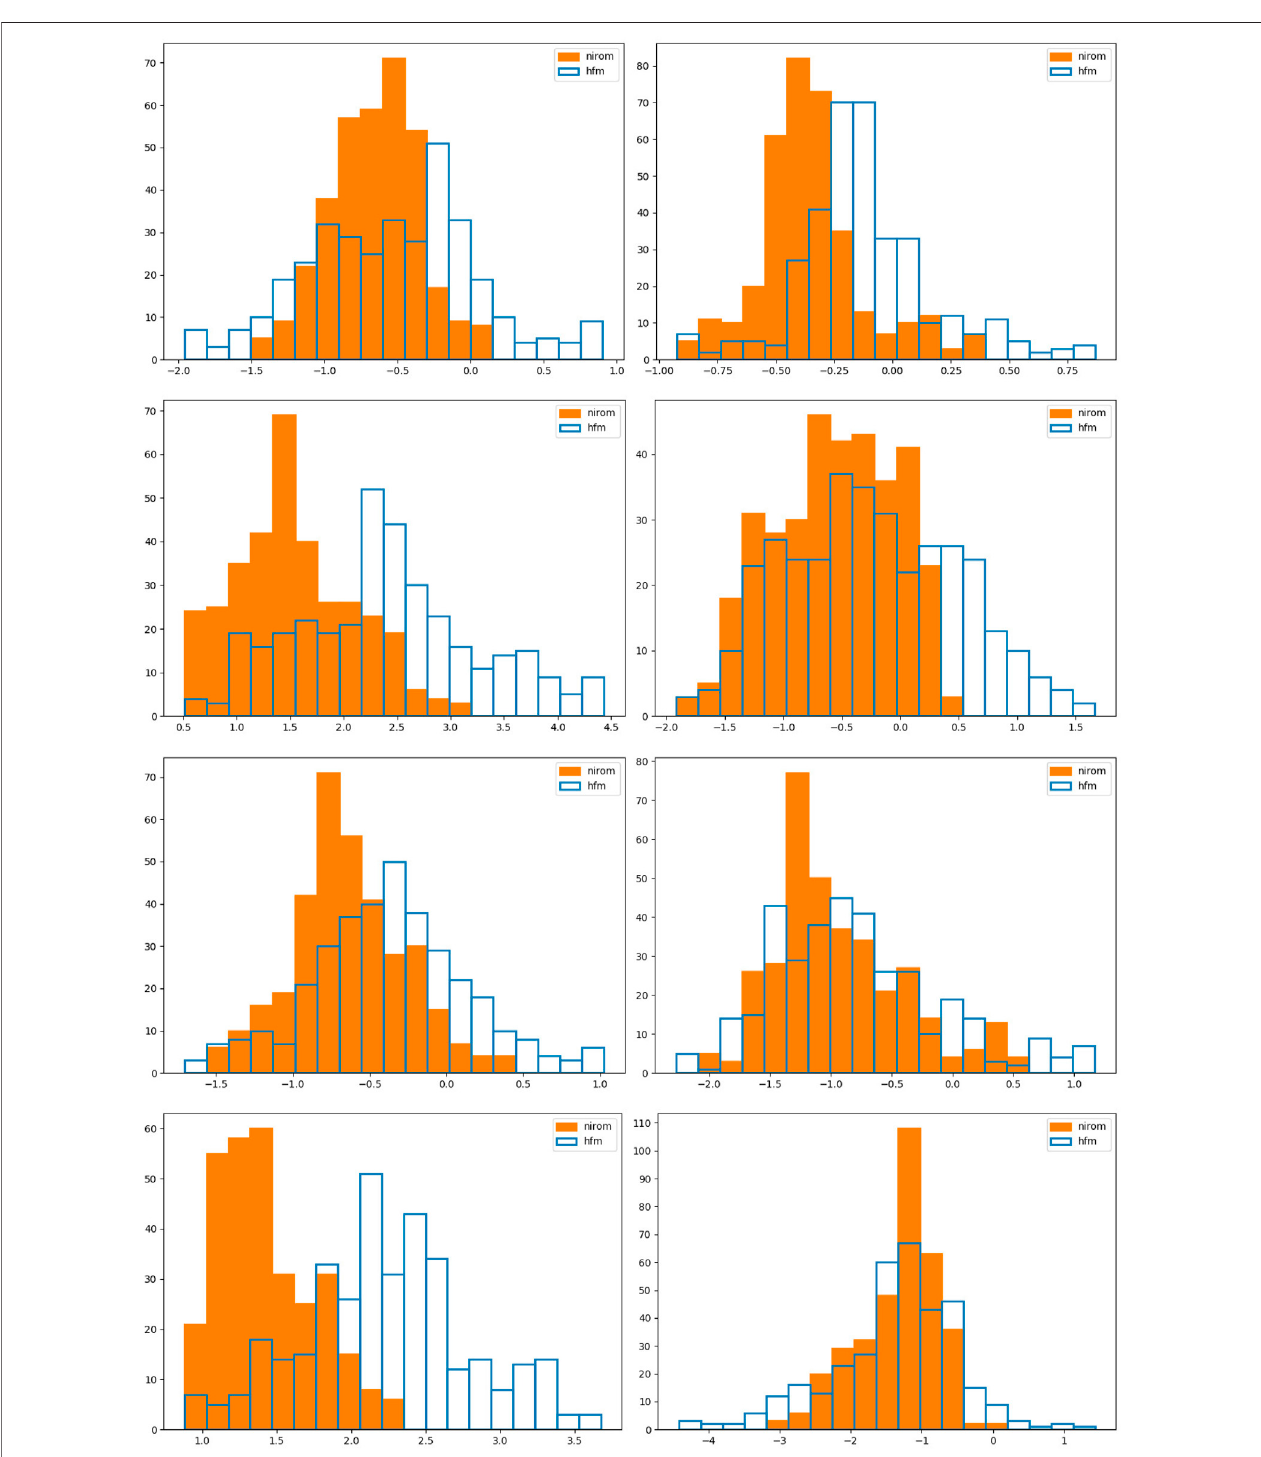
FIGURE 9 | Here we show histograms for the 6 by 6 test case at points 1, 2, 3 and 4 (see Table 3 ) in rows from top to bottom respectively. The fi rst column of graphs show the x − component of velocity and the second the y − component. We compare in these graphs the histograms (or probability density functions) of the velocity components of the HFM in blue, and NIROM in orange.